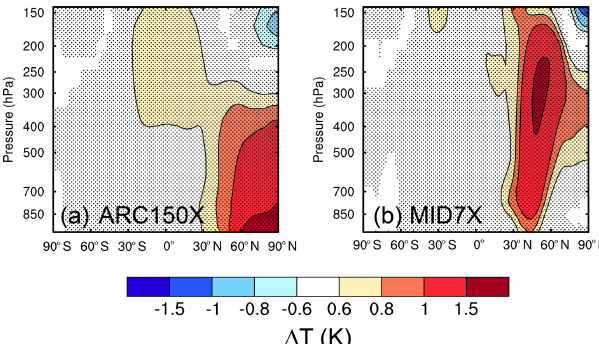
Changes in annual and zonal-mean temperature (K) for ARC150X (a) and MID7X (b) compared to PD. The dotted areas indicate statistical significance with 95% confidence from a two- tailed Student’s t